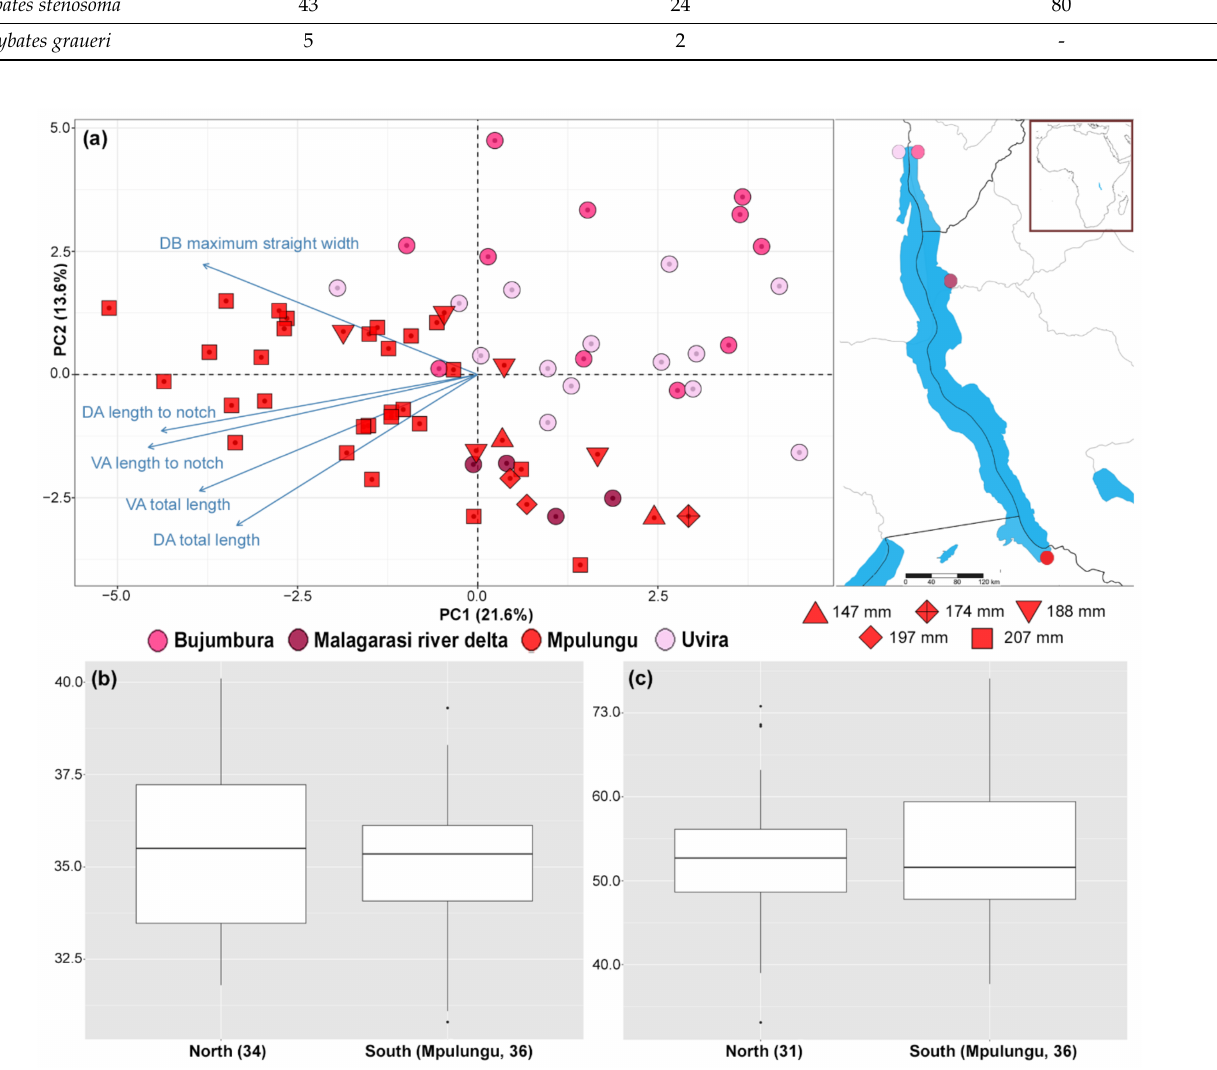
Figure 1. Morphological variation of Cichlidogyrus casuarinus ex Hemibates stenosoma from Lake Tanganyika collected at several sampling sites based on linear measurements of the haptoral and MCO sclerotised structures. ( a ) A biplot of PCA (first two axes) based on measurements of the haptoral sclerotised structures with the five most contributing variables indicated by arrows. The colours denote the locality of origin combined with signs indicating the size of the fish host that the parasite was extracted from. ( b ) Box-plot graph with a copulatory tube length of C. casuarinus ( y -axis in µ m) separated by basin. ( c ) Box-plot graph with a heel length of C. casuarinus ( y -axis in µ m) separated by basin. The number of specimens measured is indicated in